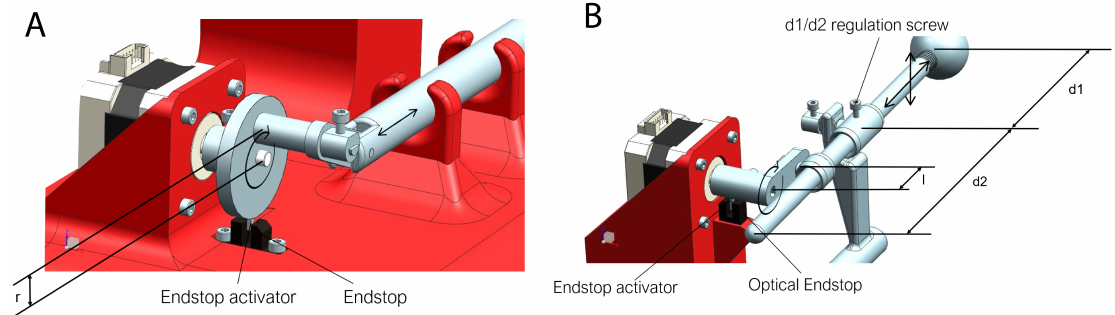
Figure 5. ( A ) Horizontal stepper motor; and ( B ) vertical stepper motor. See main text for